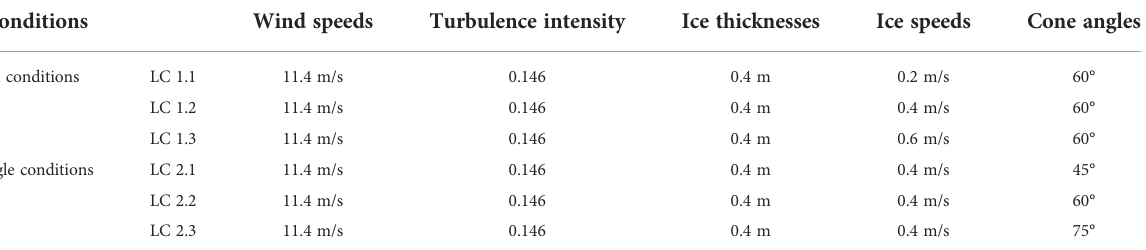
TABLE 3 Designed combined load